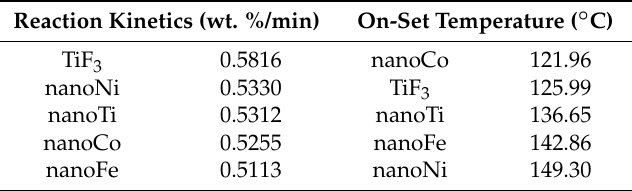
Table 1. Reaction kinetics and on-set decomposition temperature of 2LiNH 2 -nanoMgH 2 with different catalysts. Reaction Kinetics (wt. %/min)